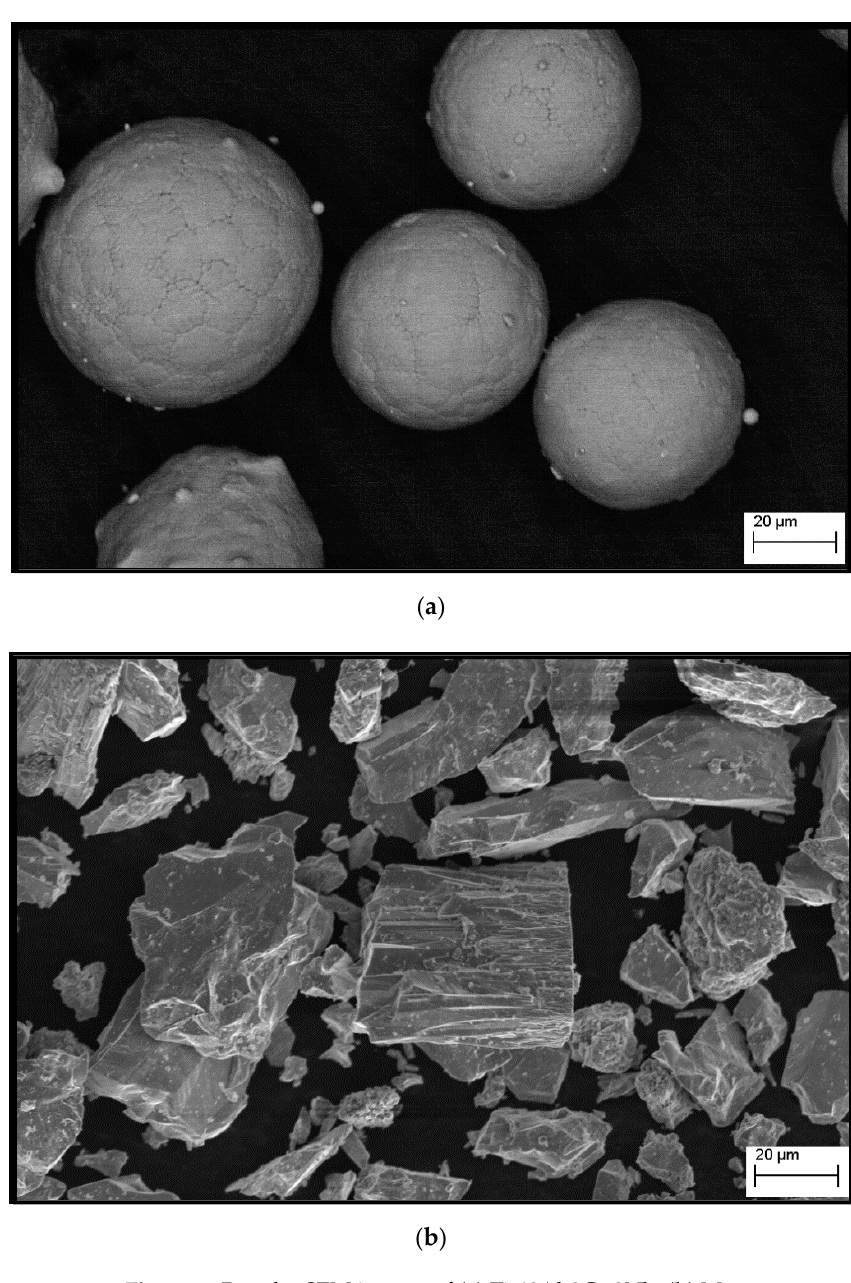
Figure 1. Powder SEM images of ( a ) Ti-48Al-2Cr-2Nb, ( b ) Mn. Table 1. Characteristics of Ti-48Al-2Cr-2Nb and Mn powders.